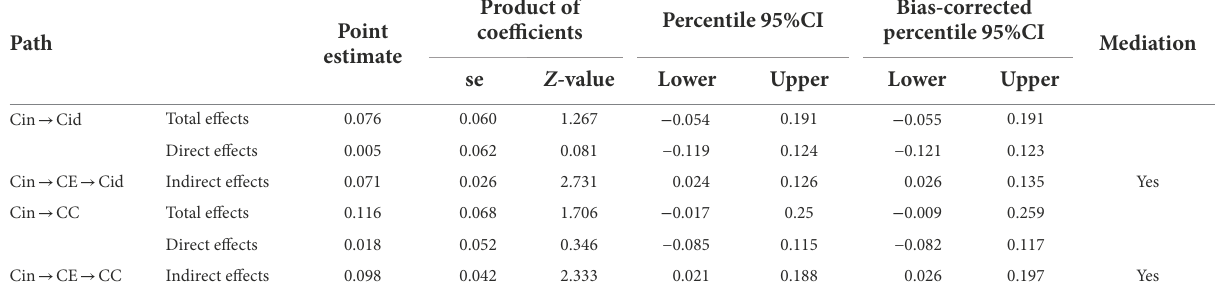
TABLE 5 Mediation